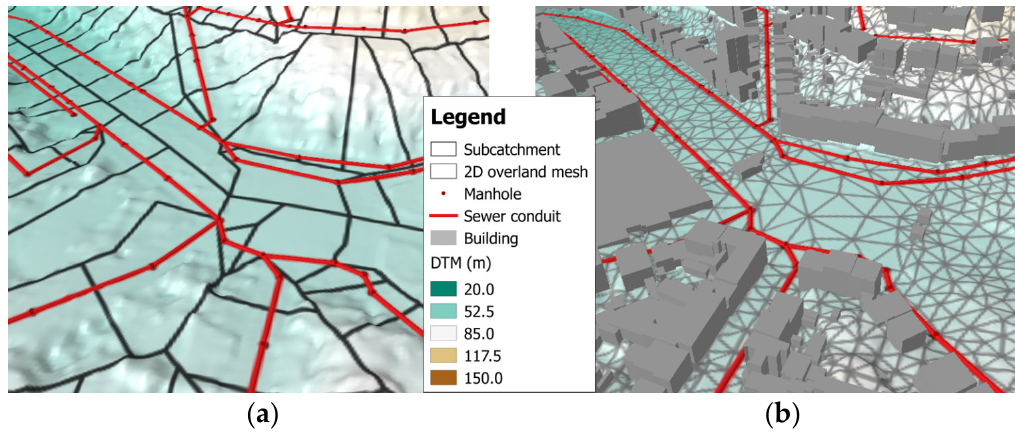
Figure 1. Semi-distributed ( a ) and fully-distributed ( b ) models.